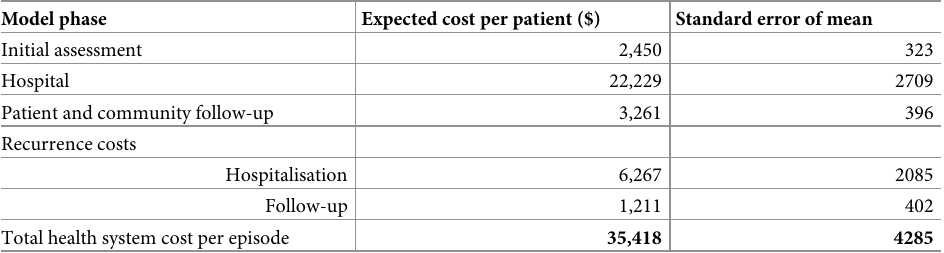
Table 8. Expected cost for each of the components of the model for patients with crusted